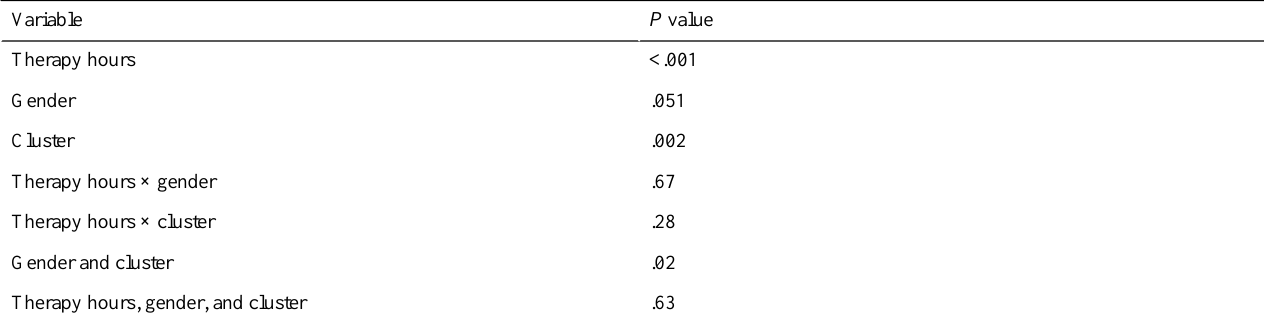
Table 3. Explanatory